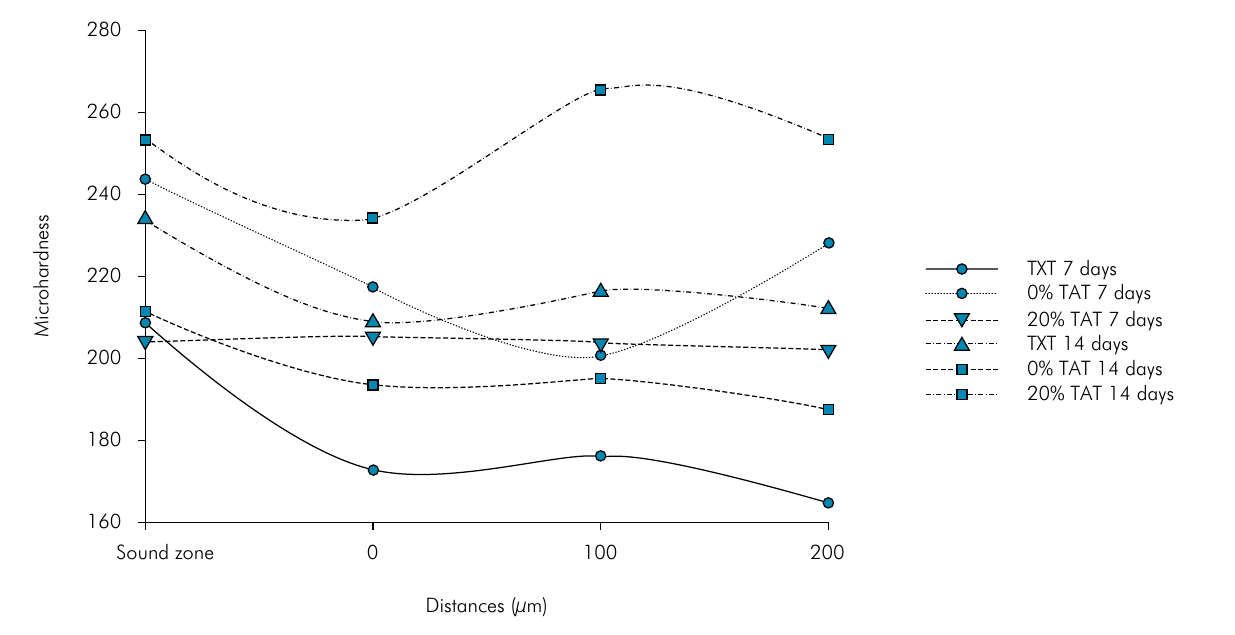
Figure 3. Mean values of enamel microhardness according to adhesive (TXT, 0% TAT, and 20% TAT) and distances (Sound zone, 0, 100, and 200